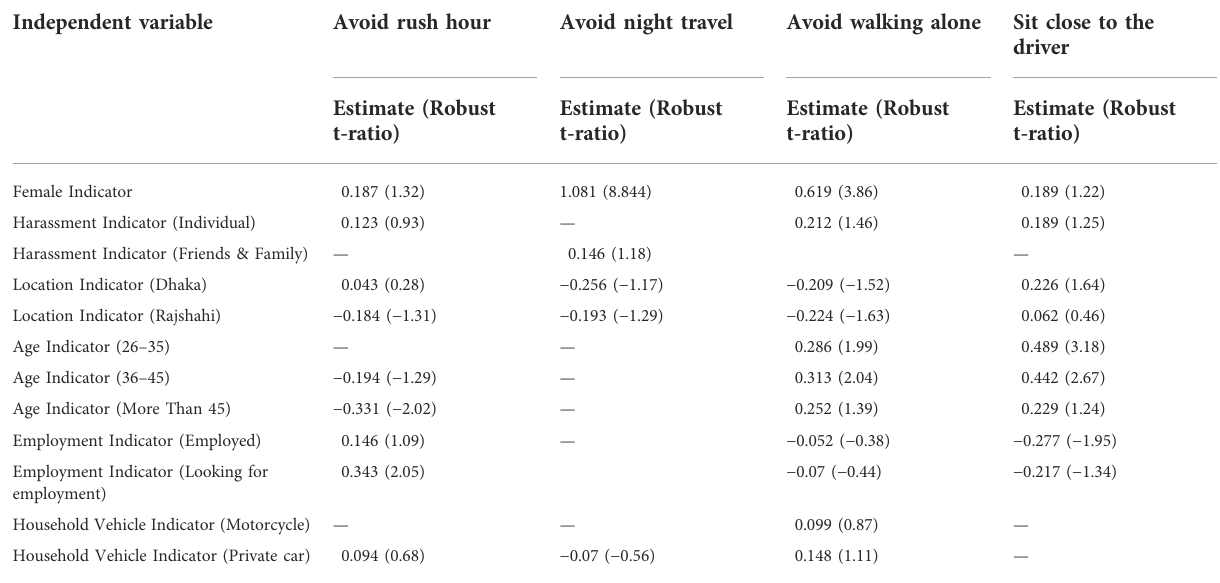
TABLE 5 Ordered probit model results on safety measures taken by